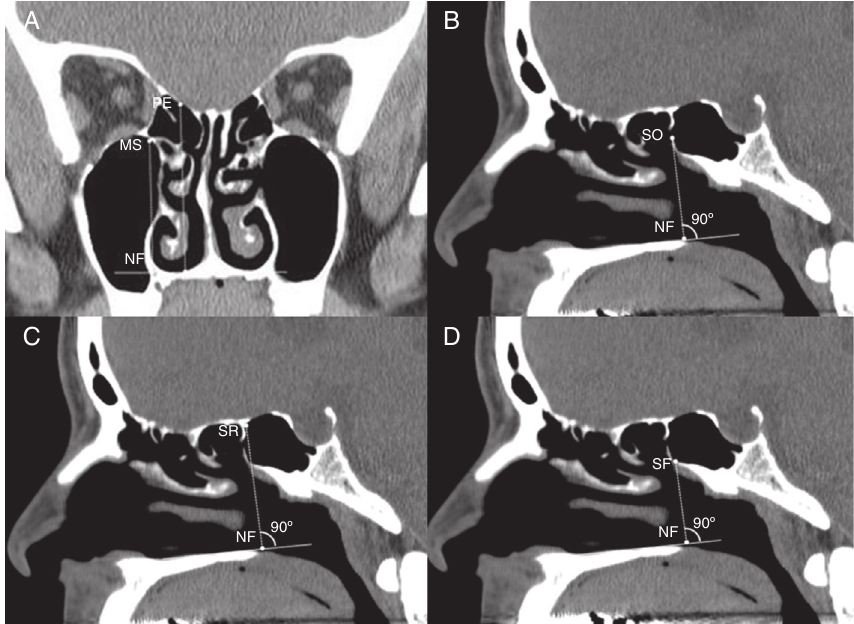
(A) Coronal CT image demonstrating the vertical distance from the nasal floor (NF) to the highest medial maxillary sinus roof (MS) and posterior ethmoid skull base (PE). (B) Sagittal CT image demonstrating the vertical distance from the nasal floor (NF) to the sphenoid ostium (SO). (C) Sagittal CT image demonstrating the vertical distance from the nasal floor (NF) to the anterior sphenoid sinus roof (SR). (D) Sagittal CT image demonstrating the vertical distance from the nasal floor (NF) to the anterior sphenoid sinus floor (SF).